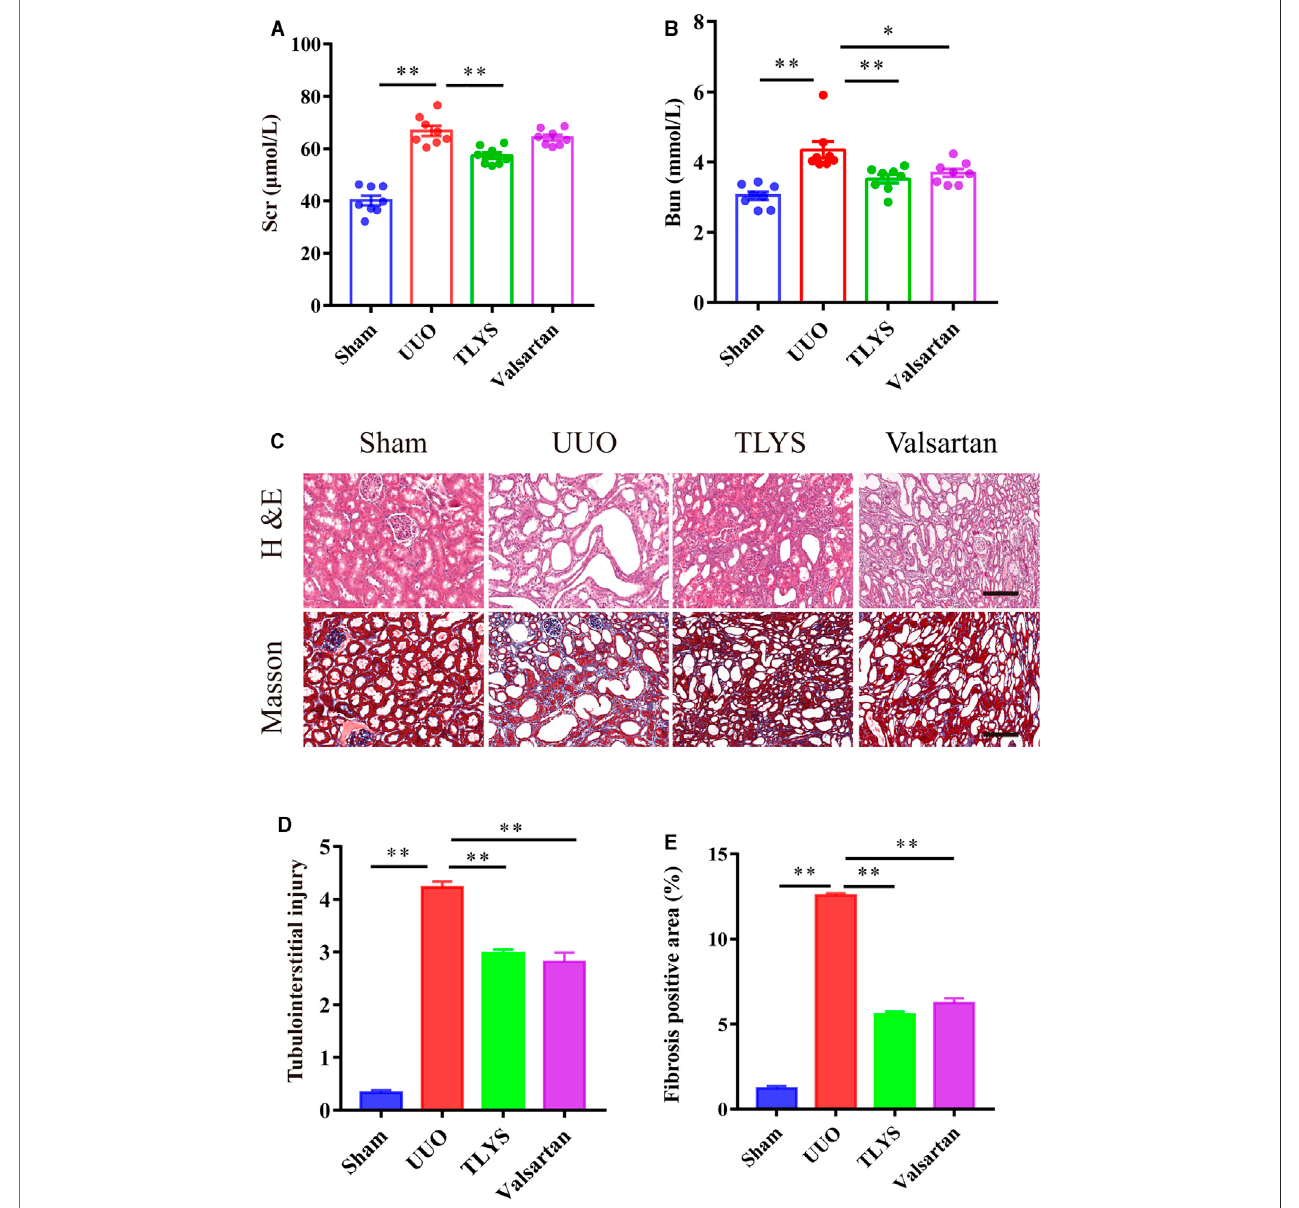
FIGURE 2 | TLYS decoction alleviates renal function and pathological kidney injuries in UUO rats. (A,B) serum creatinine and BUN were detected ( n (cid:2) 8). (C) H&E and Masson ’ s trichrome were performed to evaluate kidney injury ( n (cid:2) 6). (D) Tubular damage scores based on H&E staining. (E) quanti fi cation of collagen areas according to Masson ’ s trichrome staining. The magni fi cation of the images is × 200, scale bar (cid:2) 50 μ m. Data were presented as means ± SEM. * p < 0.05, ** p < 0.01.